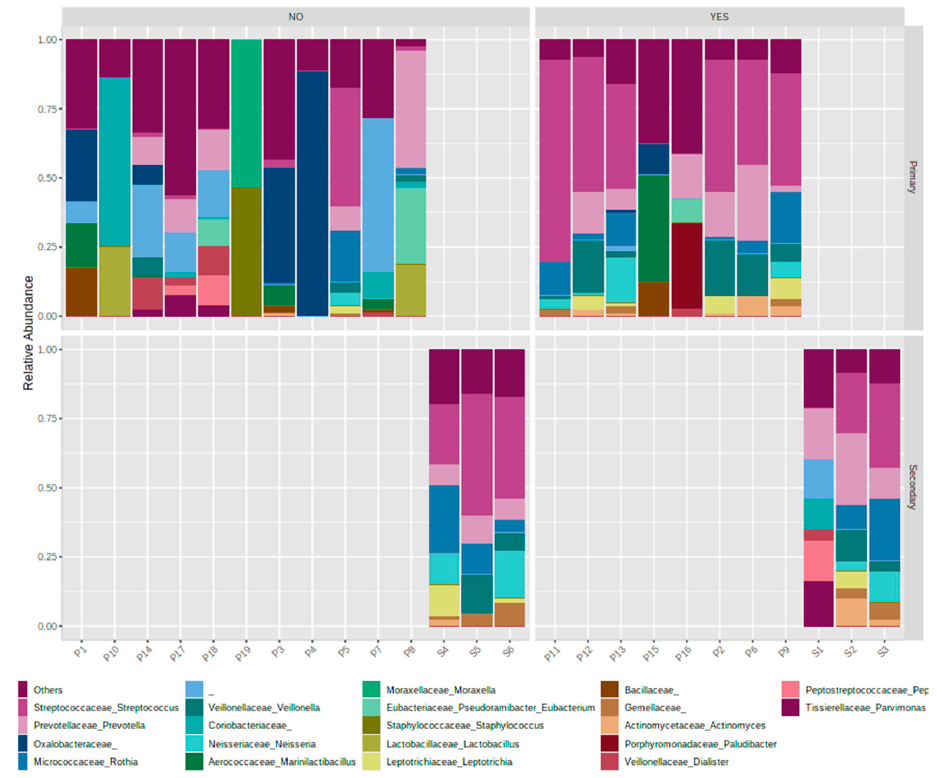
Figure 1. Taxonomic distribution and richness at genus level for samples across all endodontic infection samplesfor individual samples of primary (P1–19) and secondary cases (S1–6), delineated by Entamoeba status (YES/NO) and infection type (primary/secondary). Entamoeba positive cases displayed a reduced heterogeneity of genera present with predominance of taxa Streptococcus sp. , Prevotella sp. and Rothia